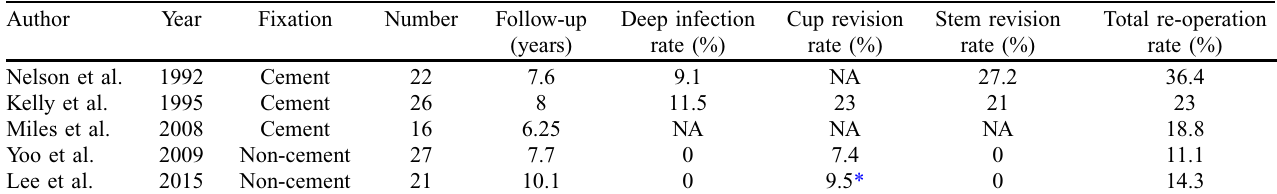
Table 1. Previous articles of THAs in patients with